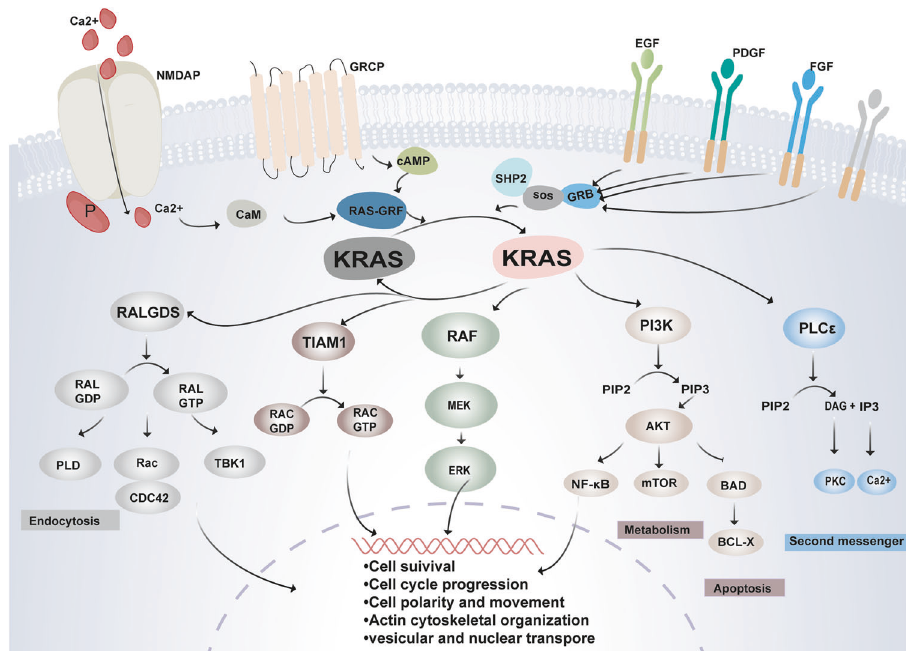
Fig. 2 The regulation of KRAS activation and signal transduction. The canonical and well-known pattern of activating KRAS is dependent on correct membrane localisation and adjacent activation of membrane receptors. In the resting state, KRAS normally binds with GDP in an inactivated state. When the extracellular growth factors such as EGF transmit signals to receptors, the SOS, a kind of GEF, interacts with the KRAS-GDP complex leading to the release of GDP and the replacement of GTP. The tether of GTP and KRAS induces structural changes of switch I and switch II, thereby activating KRAS. In contrast, GAPs enhance intrinsic GTPase activity in KRAS to accelerate the reaction in which GTP is hydrolysed to GDP. The KRAS cycle between the activated and inactivated conformations functions as a fi nely regulated molecular